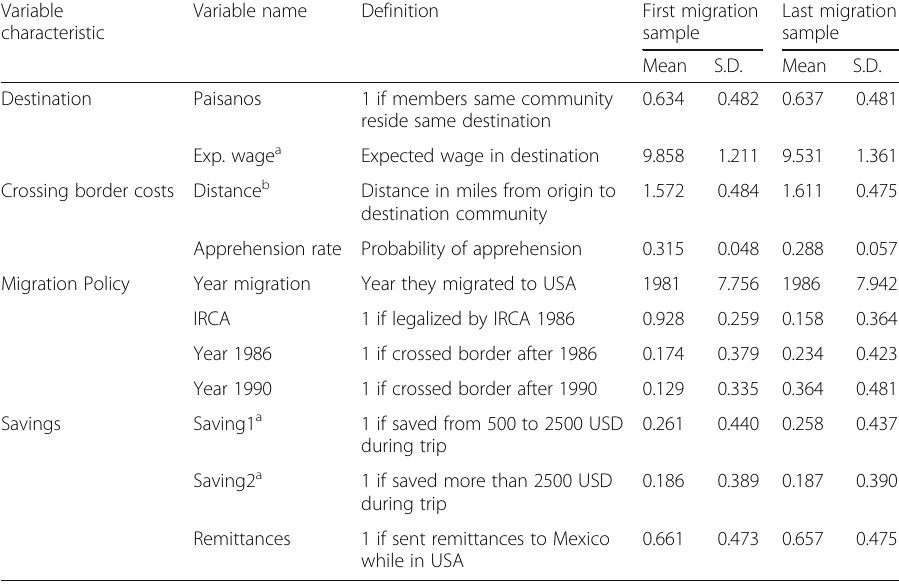
Table 3 Summary statistics Variable